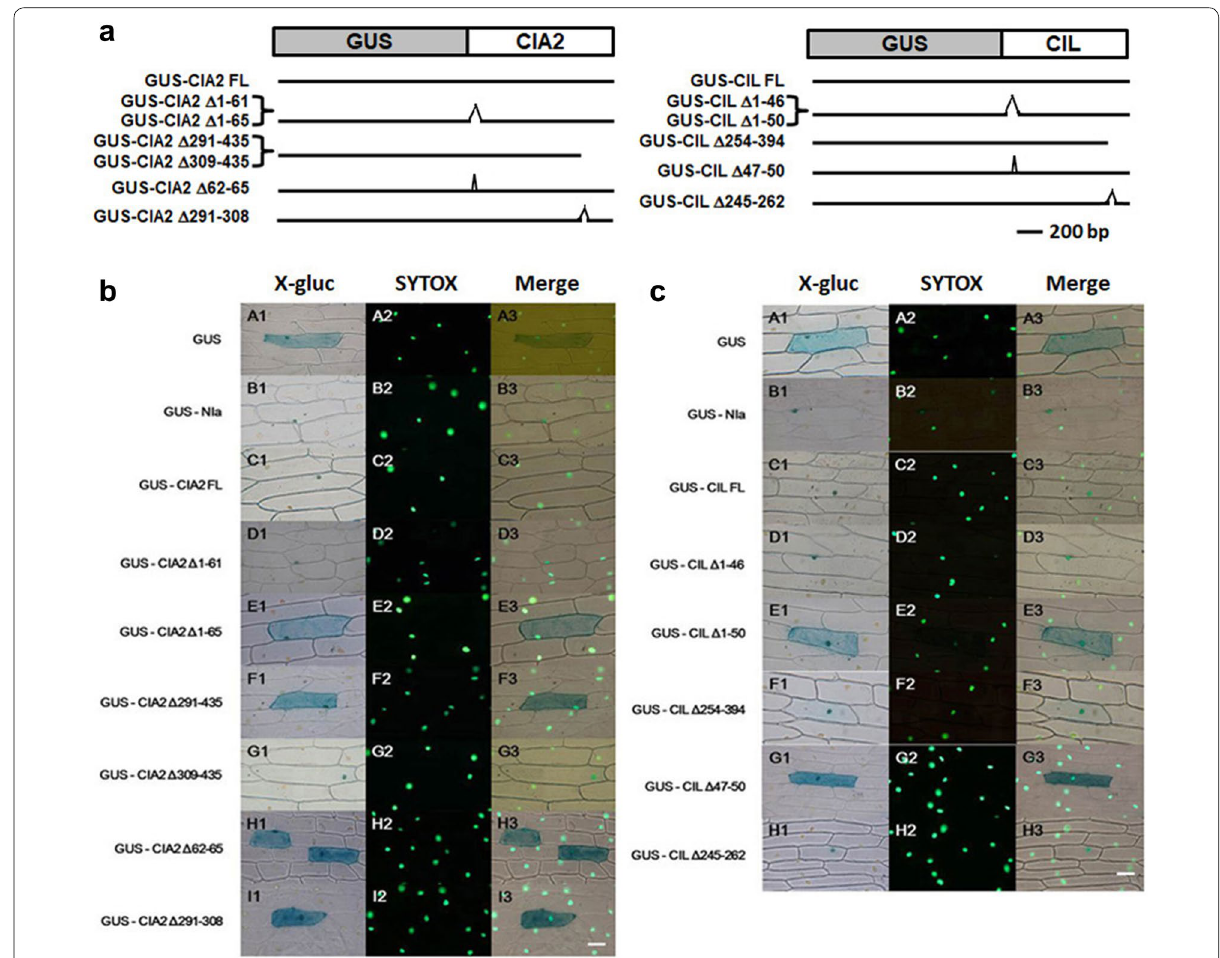
Fig. 1 Cellular localizations of CIA2 and CIL fragments. Plasmids encoding various protein fragments, as labeled at left, were transformed into onion epidermal cells by means of particle bombardment. Samples were stained simultaneously with X‑gluc and the nucleus‑specific dye SYTOX. a Schematic diagram of the constructs used in this experiment. b CIA2‑related constructs. c CIL‑related constructs. Left row, visualization of X‑gluc staining; middle row, visualization of SYTOX staining; right row, superimposition of X‑gluc and SYTOX staining. Scale bars in b and c represent 50